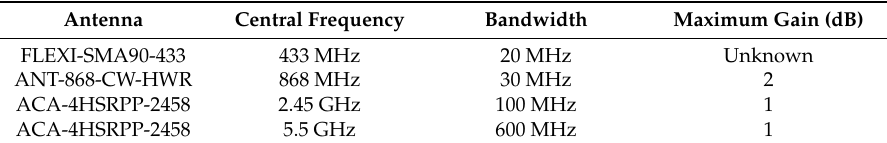
Table 2. Characteristics of the antennas used for measurements.